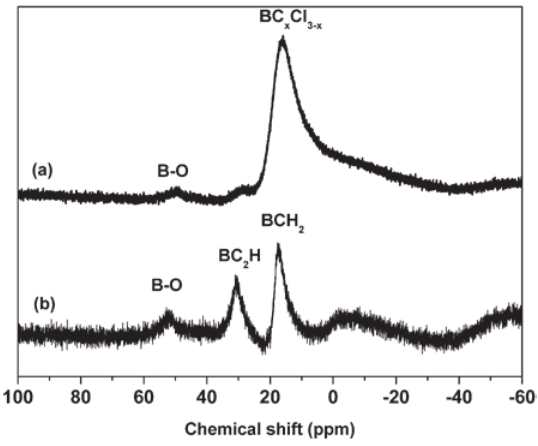
Fig. 6: 11 B { 1 H} NMR spectra of (a) choloropolyborocarbosilane and (b) HPBCS-3.